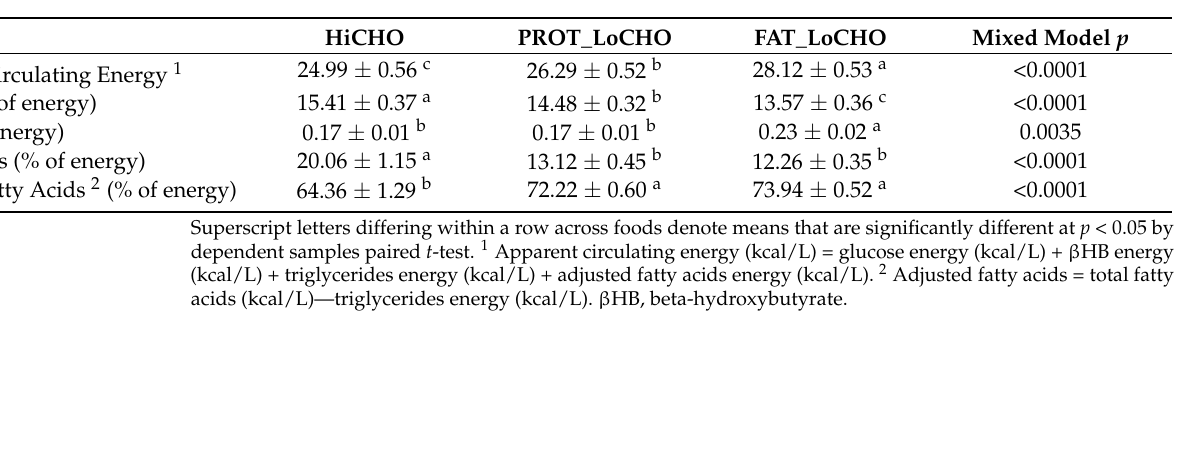
Table 8. Serum total apparent circulating energy and constituents